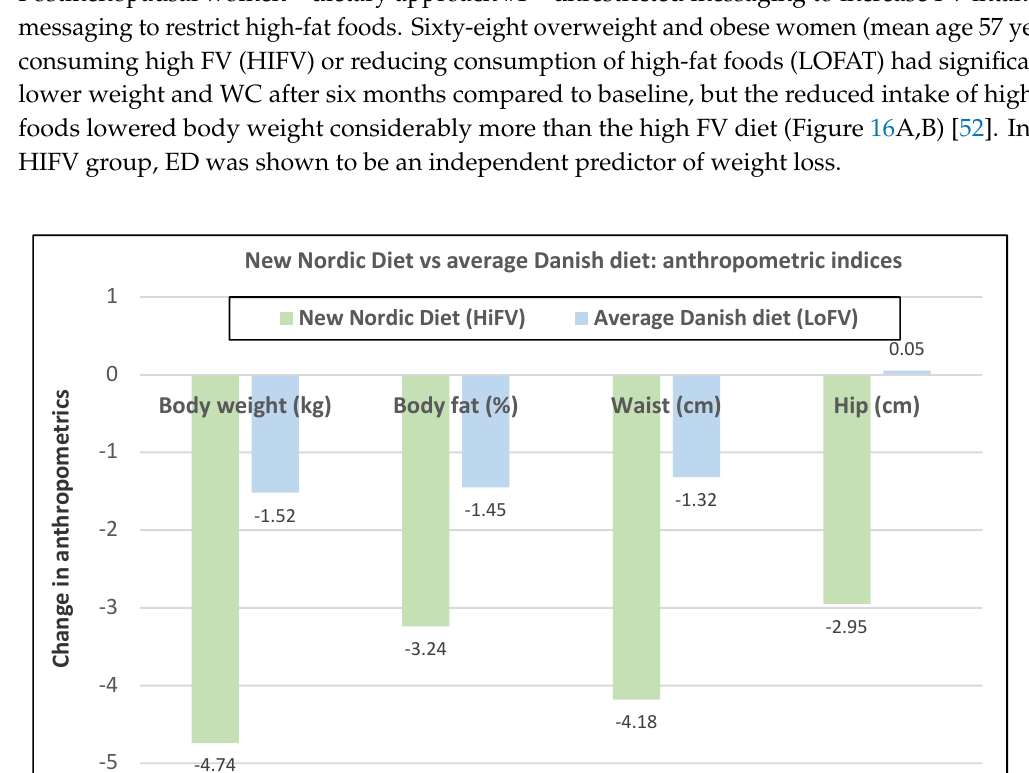
Premenopausal women—dietary approach #1—ad libitum diets high in healthy FV and restricting higher ED foods vs. a Western-type diet. Centrally obese adults (71% women; mean baseline age 42 years, BMI of 30, and WC of 100 cm) consuming the New Nordic Diet (high in FV) significantly lowered body weight and fat, and waist and hip circumferences compared to the average Danish diet (low in FV) over 26 weeks (Figure 9) [40]. The New Nordic diet reduced